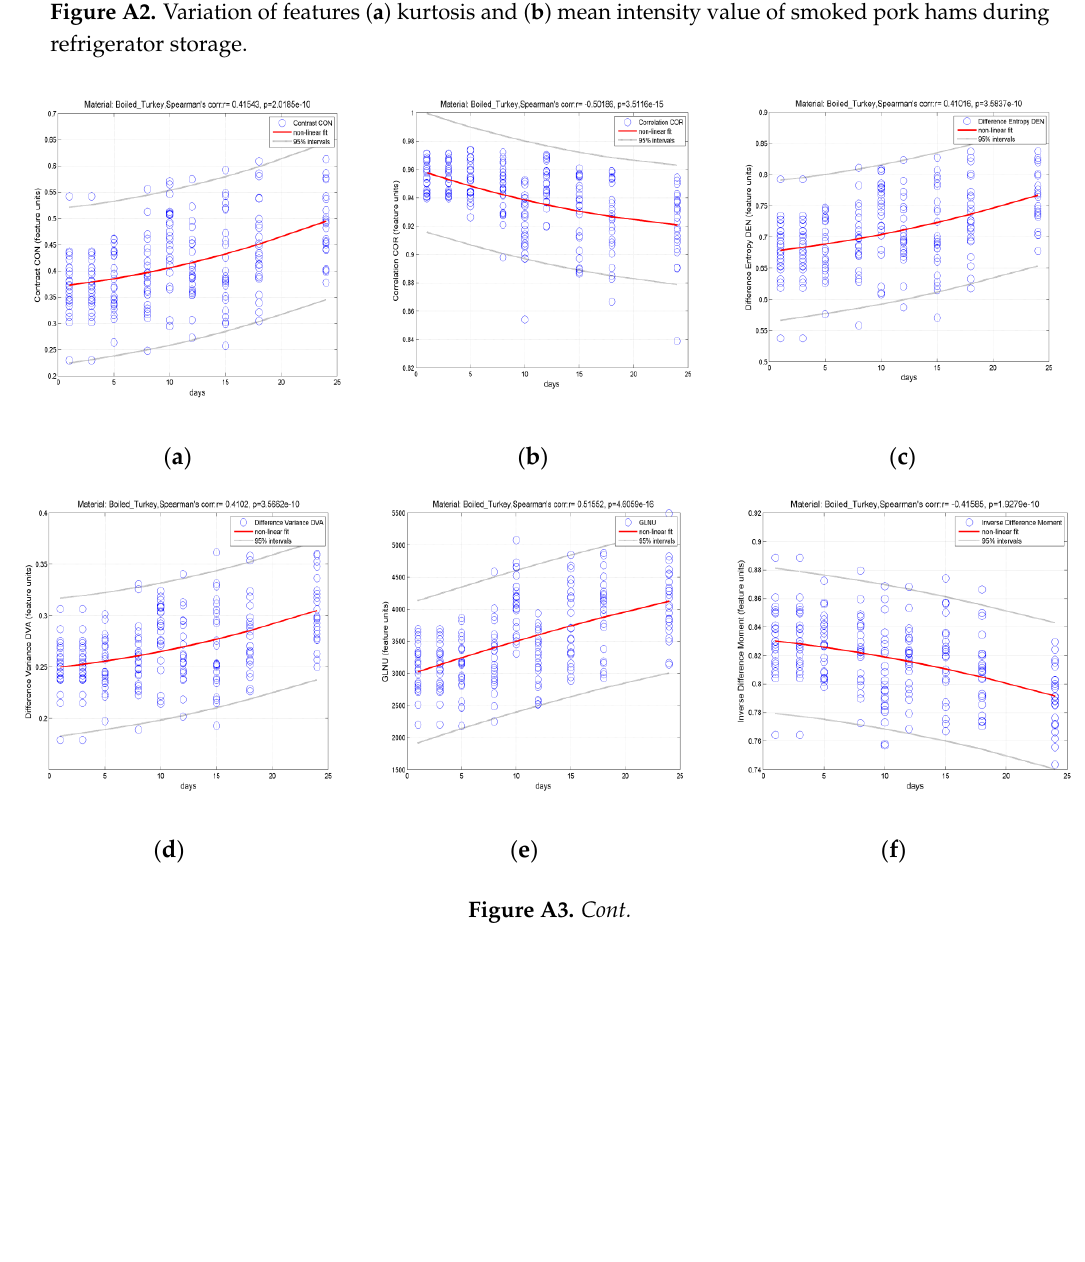
Figure A3. Variation of features ( a ) contrast, ( b ) correlation, ( c ) difference entropy, ( d ) difference variance, ( e ) great level non-uniformity, ( f ) inverse different moment, ( g ) mean intensity value, ( h ) run length non-uniformity and ( i ) run percentage of boiled turkey hams during refrigerator storage.